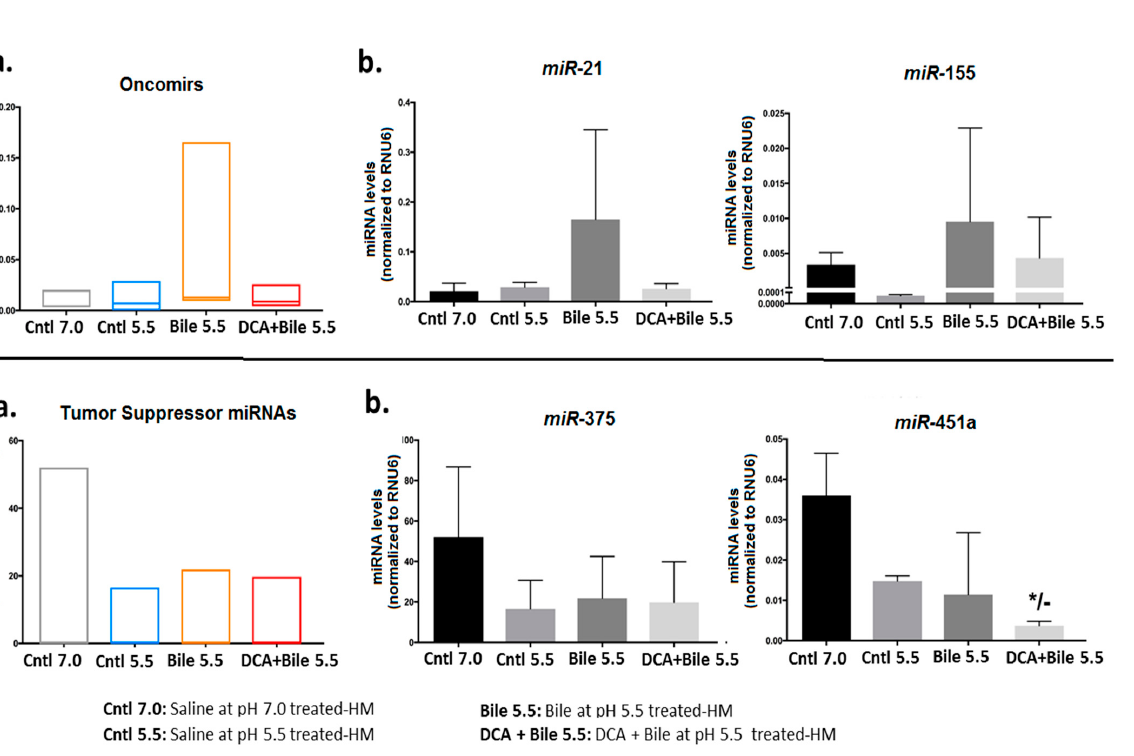
Figure 5. Weakly acidic bile-induced deregulation of the miRNA oncogenic phenotype in murine hypopharyngeal mucosa (HM) after 15 weeks of exposure. ( A ) ( a ) Graph depicts total “oncomirs” levels after exposure to bile at pH 5.5 with or without DCA vs. controls (one-way ANOVA; Graph Pad Prism software 7.0) ( b ) Graphs indicate expression levels for each analyzed “oncomir” miR -21 and miR -155 after exposure to weakly acidic bile vs. controls (Graph Pad Prism software 7.0). ( B ) ( a ) Graph depicts total “tumor suppressor” miRNA levels after exposure to bile at pH 5.5 with or without DCA vs. controls (one-way ANOVA; Graph Pad Prism software 7.0) ( b ). Graphs indicate expression levels for each analyzed “tumor suppressor” miR -375 and miR -451a after exposure to weakly acidic bile vs. controls. (* p < 0.01; t -test; multiple comparisons using Holm-Sidak; GraphPad Prism 7.0). (By real-time qPCR analysis; data obtained from four analyzed samples).